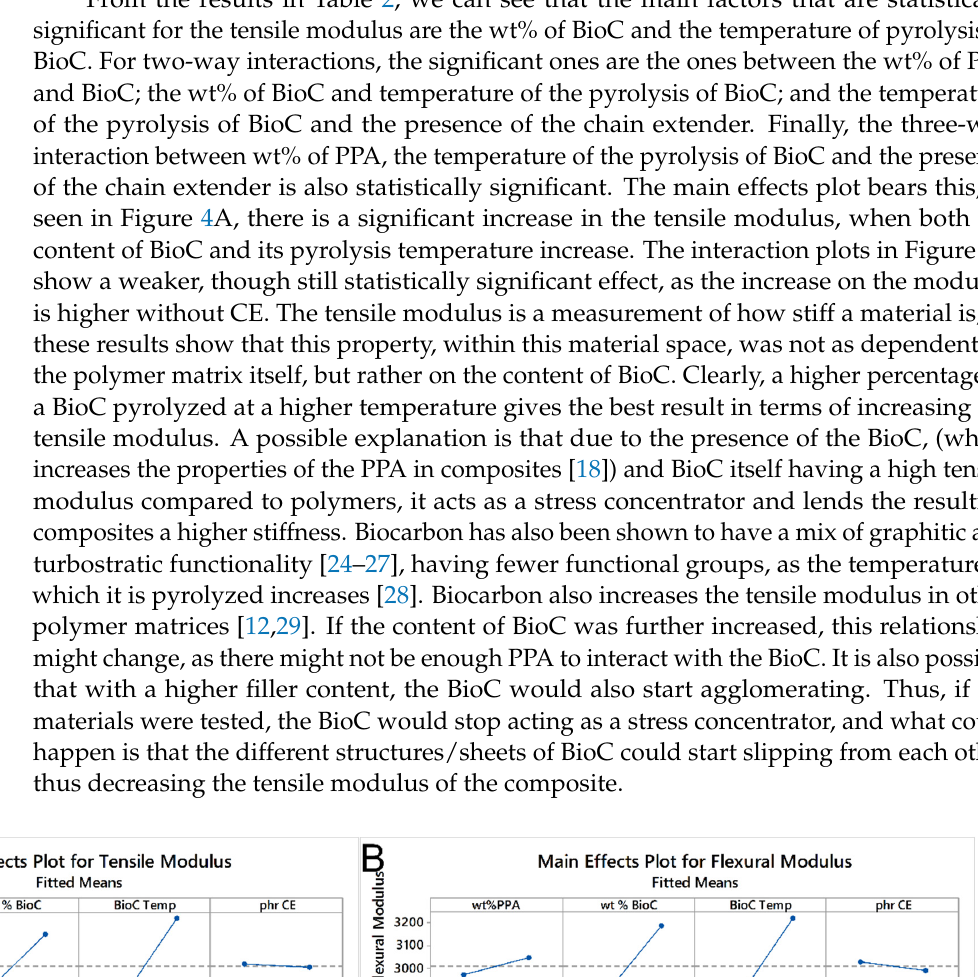
Figure 5. Interaction plots for the effects that the interactions between the main factors of wt%% PPA, wt% BioC, and the temperature of pyrolysis of BioC have on ( A ) tensile modulus, ( B ) flexural modulus, ( C ) HDT and ( D ) density. For the flexural modulus, as seen in Table 2, the main factors of content of PPA, BioC and the pyrolysis temperature of BioC, are all statistically significant. In the case of two- way interactions, the ones that are statistically significant are the ones between the BioC content and its pyrolysis temperature; the content of BioC and the presence of CE; and the